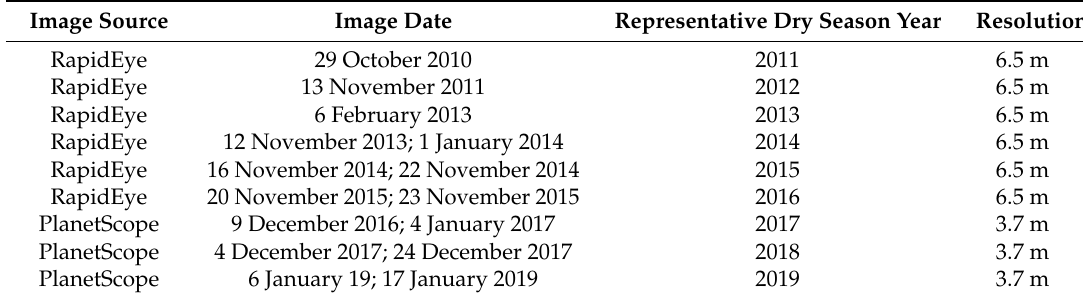
Table 2. Imagery used to estimate End Point Rate (EPR) and Linear Regression Rate